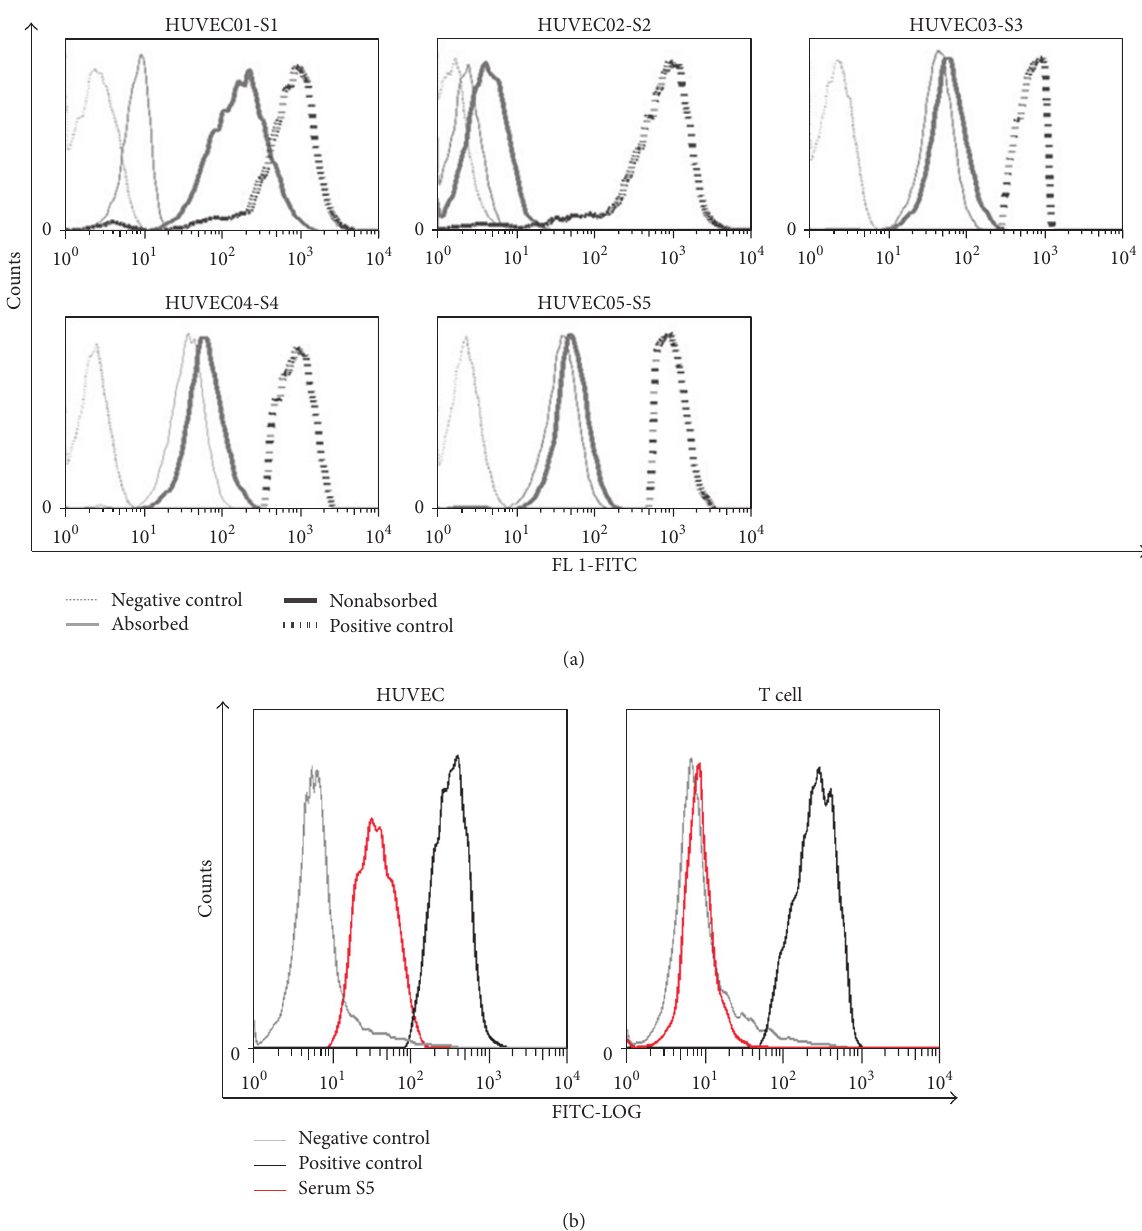
Figure 1: Isolation and identification of AECAs from posttransplant sera. (a) Sera samples from five patients were analyzed by flow cytometry for crossmatches using HUVECs. Normal human serum was used as negative control; HLA-sensitized pooled sera were used as positive control. Profiles before platelet absorption and after platelet absorption are shown. (b) Sample S5 was analyzed by flow cytometry in the presence of HUVEC and cord blood T lymphocytes. The negative control was normal human serum (NC), and the positive control was HLA-sensitized pooled